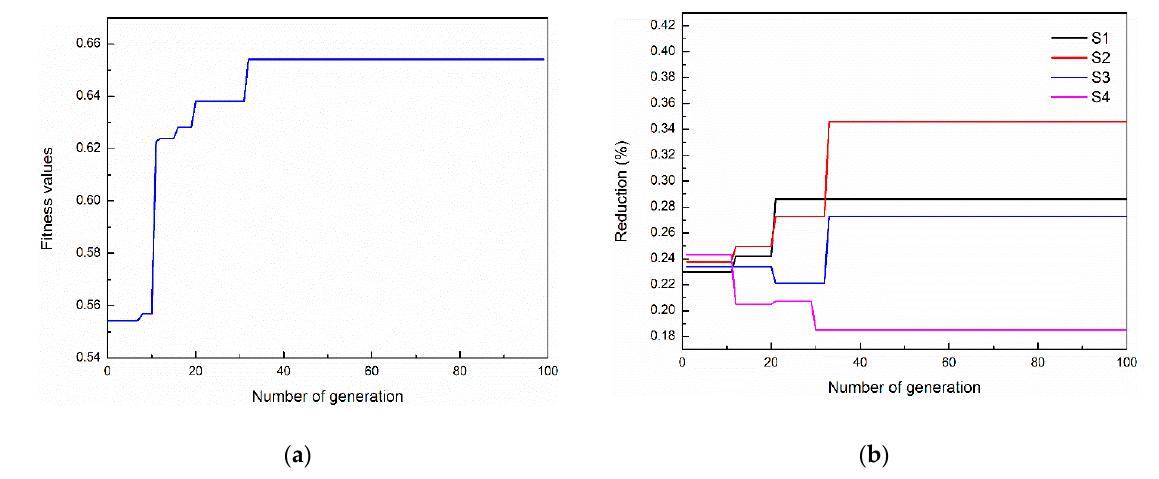
Figure 13. The ( a ) best fitness evolution for genetic algorithm and ( b ) reduction evolution.